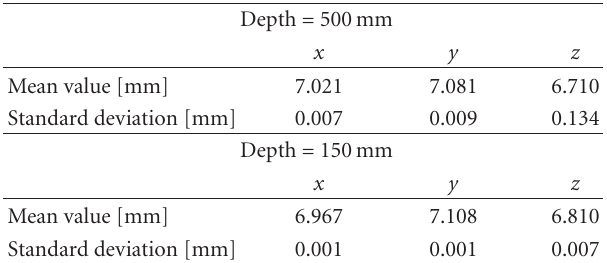
performed online, the solution of the PnP algorithm for 4 coplanar points is fast enough to be implemented online during the motion of the robot.